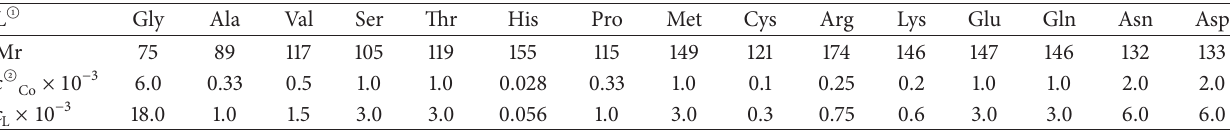
Table 1: Concentrations of 15 amino acids and cobalt